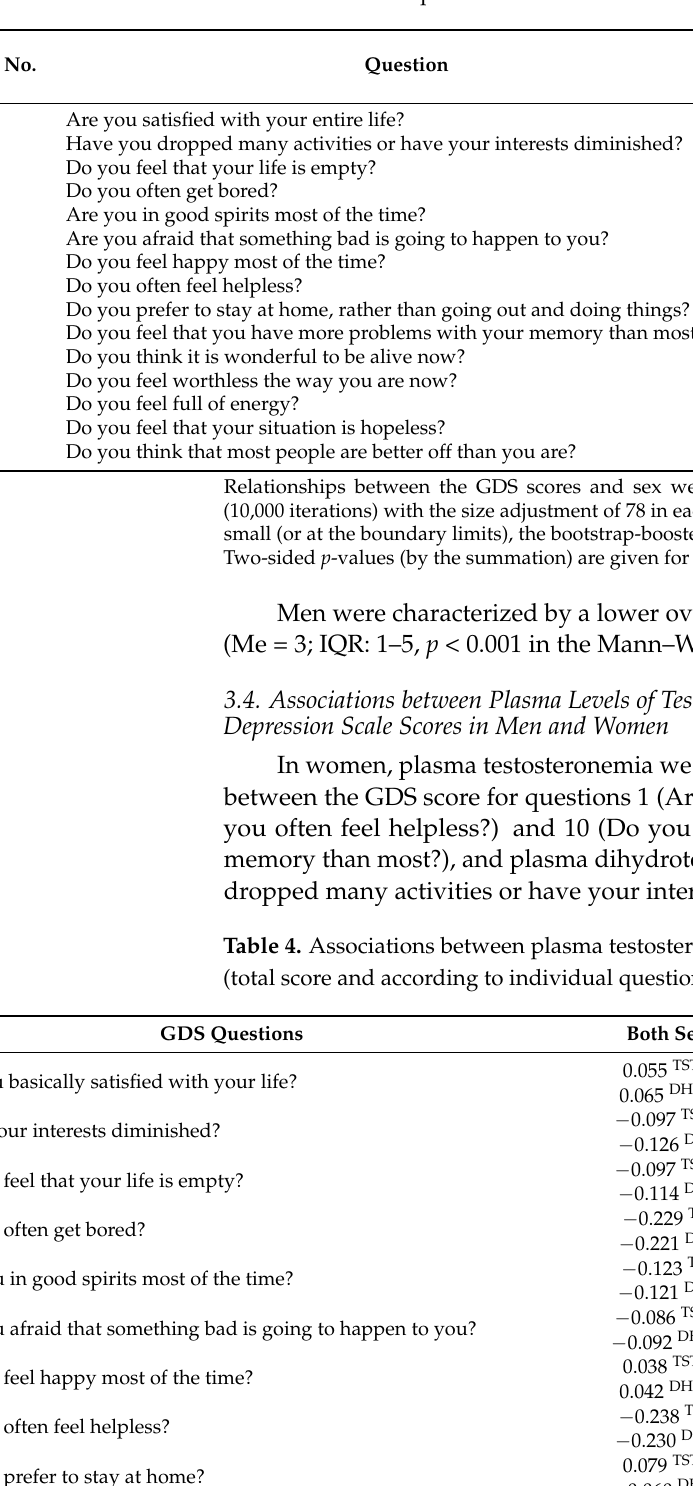
Table 3. Relationships between GDS scores and sex of the studied individuals.